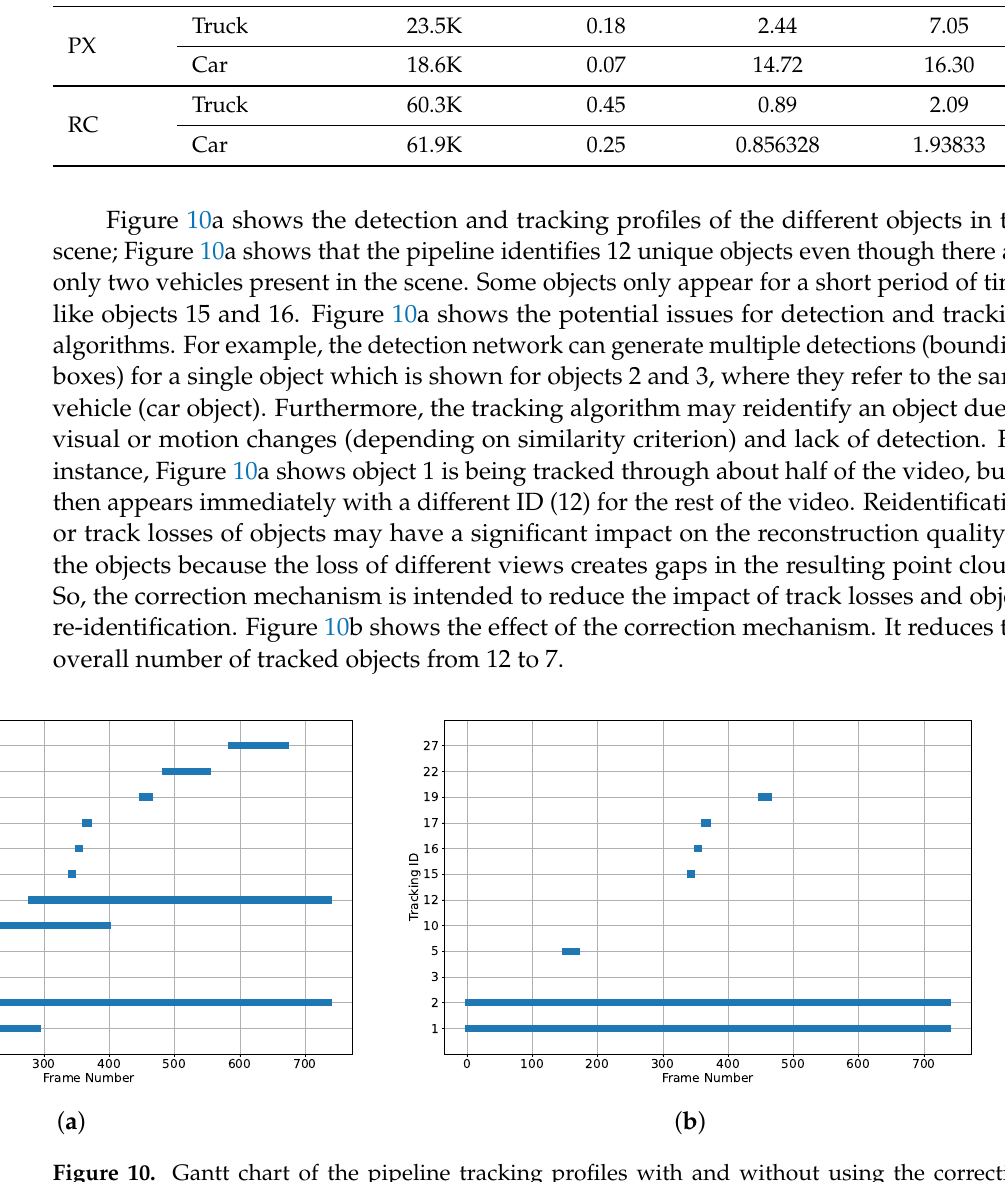
Figure 10. Gantt chart of the pipeline tracking profiles with and without using the correction mechanism showing the time span of each distinct object ID over the entire video. ( a ) Tracking profiles without the correction mechanism. ( b ) Tracking profiles using the correction mechanism which identifies and merges duplicate